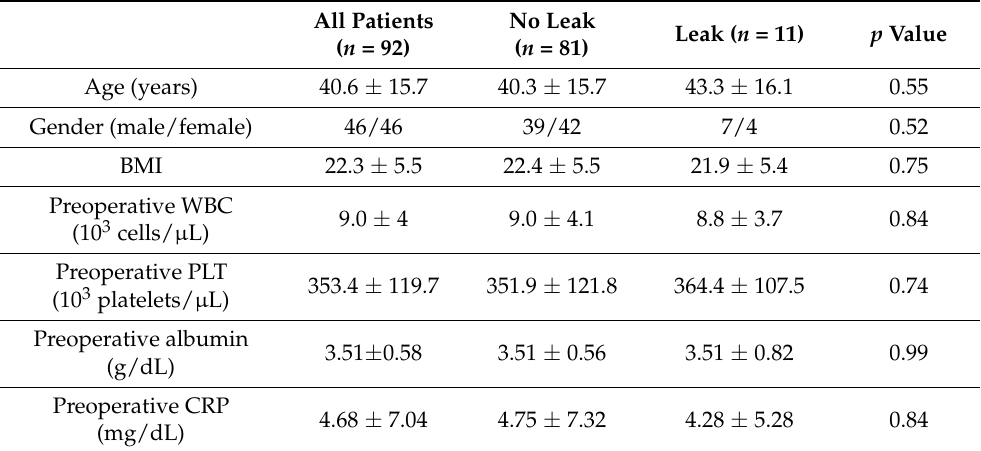
Table 1. Demographics and preoperative inflammatory markers. All